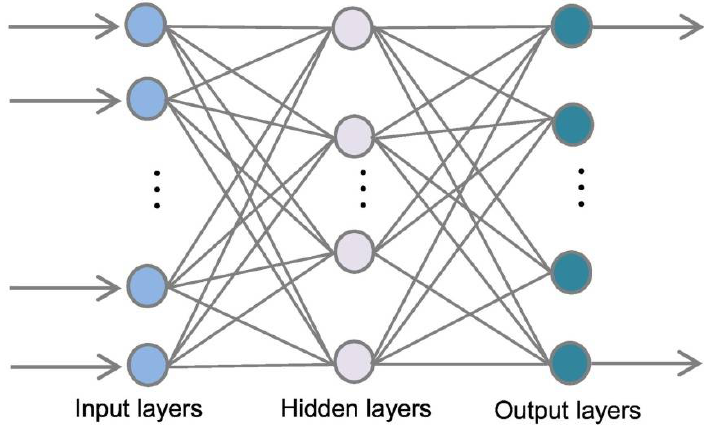
Figure 4. Structure of the MLP [21].